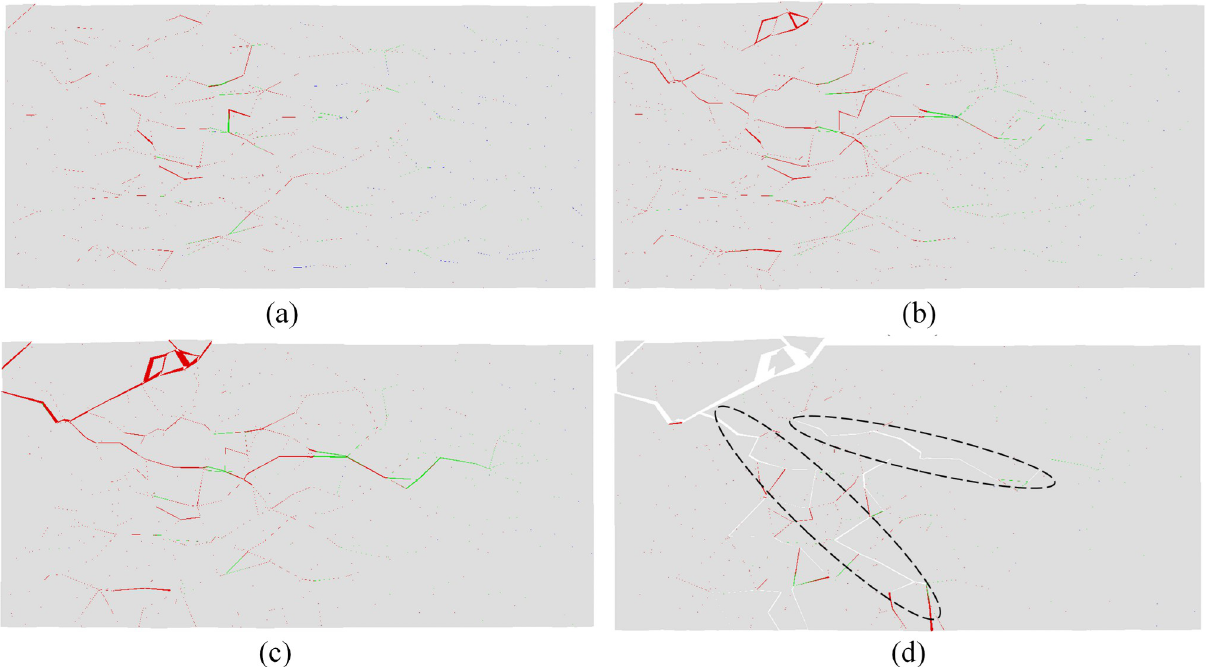
Fig 10. Progressive fracture process of the slice at a velocity of 20.0 m/s (the left face is the impacting face, and the red and green traces depict the cohesive element that has been deleted mainly due to shear failure and tensile failure, respectively): (a) at 0.04 ms; (b) at 0.08 ms; (c) at 0.12 ms; (d) at 0.12 ms, the deleted cohesive elements are not displayed.